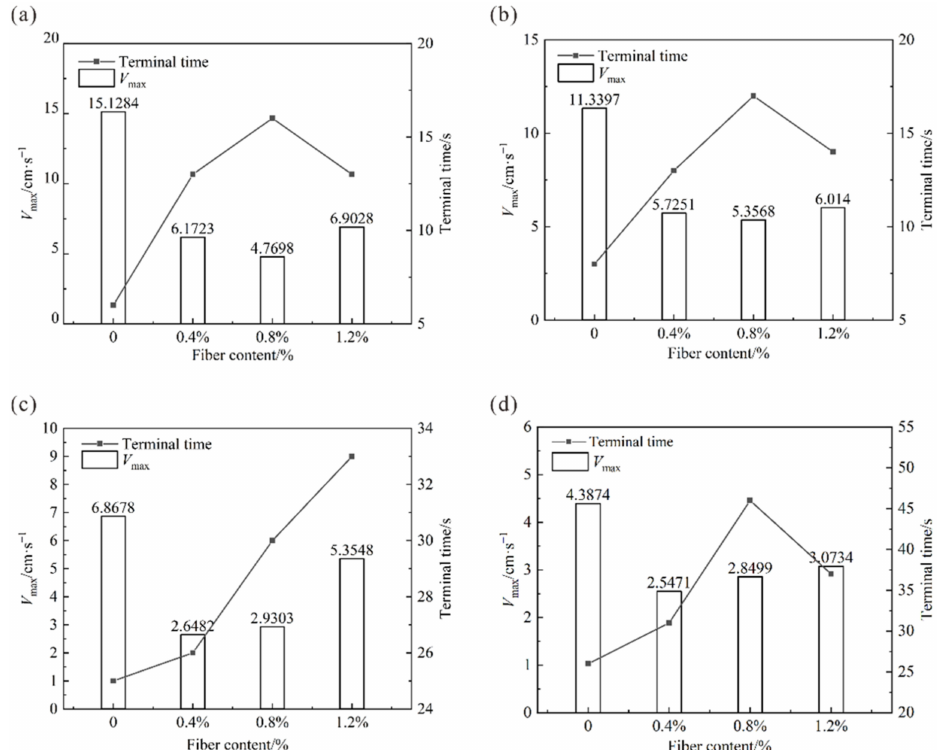
Figure 7. Sliding time and peak speed of fiber-reinforced clay at the moisture content of ( a ) 45%, ( b ) 40%, ( c ) 35%, and ( d ) 30%.